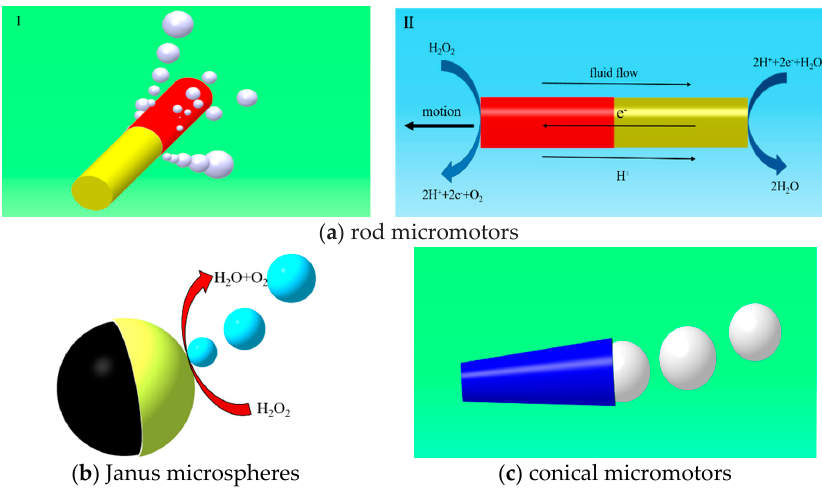
Figure 1. The proposed mechanisms for micromotors of different geometries. ( a ) There are two propelled mechanisms for rod micromotors: (I) the rod micromotors are propelled by bubbles generated at the surface at one end of microrods [23], and (II) the electrokinetic mechanisms of microrods [24]; ( b ) bimetal Janus microspheres propelled by diffusing of bubbles at the surface of microspheres; ( c ) conical micromotors propelled by growth and jet of bubbles generated by chemical catalytic reactions.